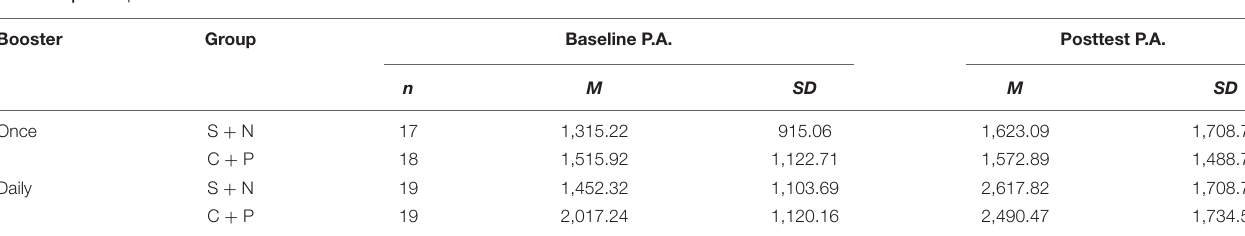
TABLE 5 | Descriptive statistics of exercise amount.